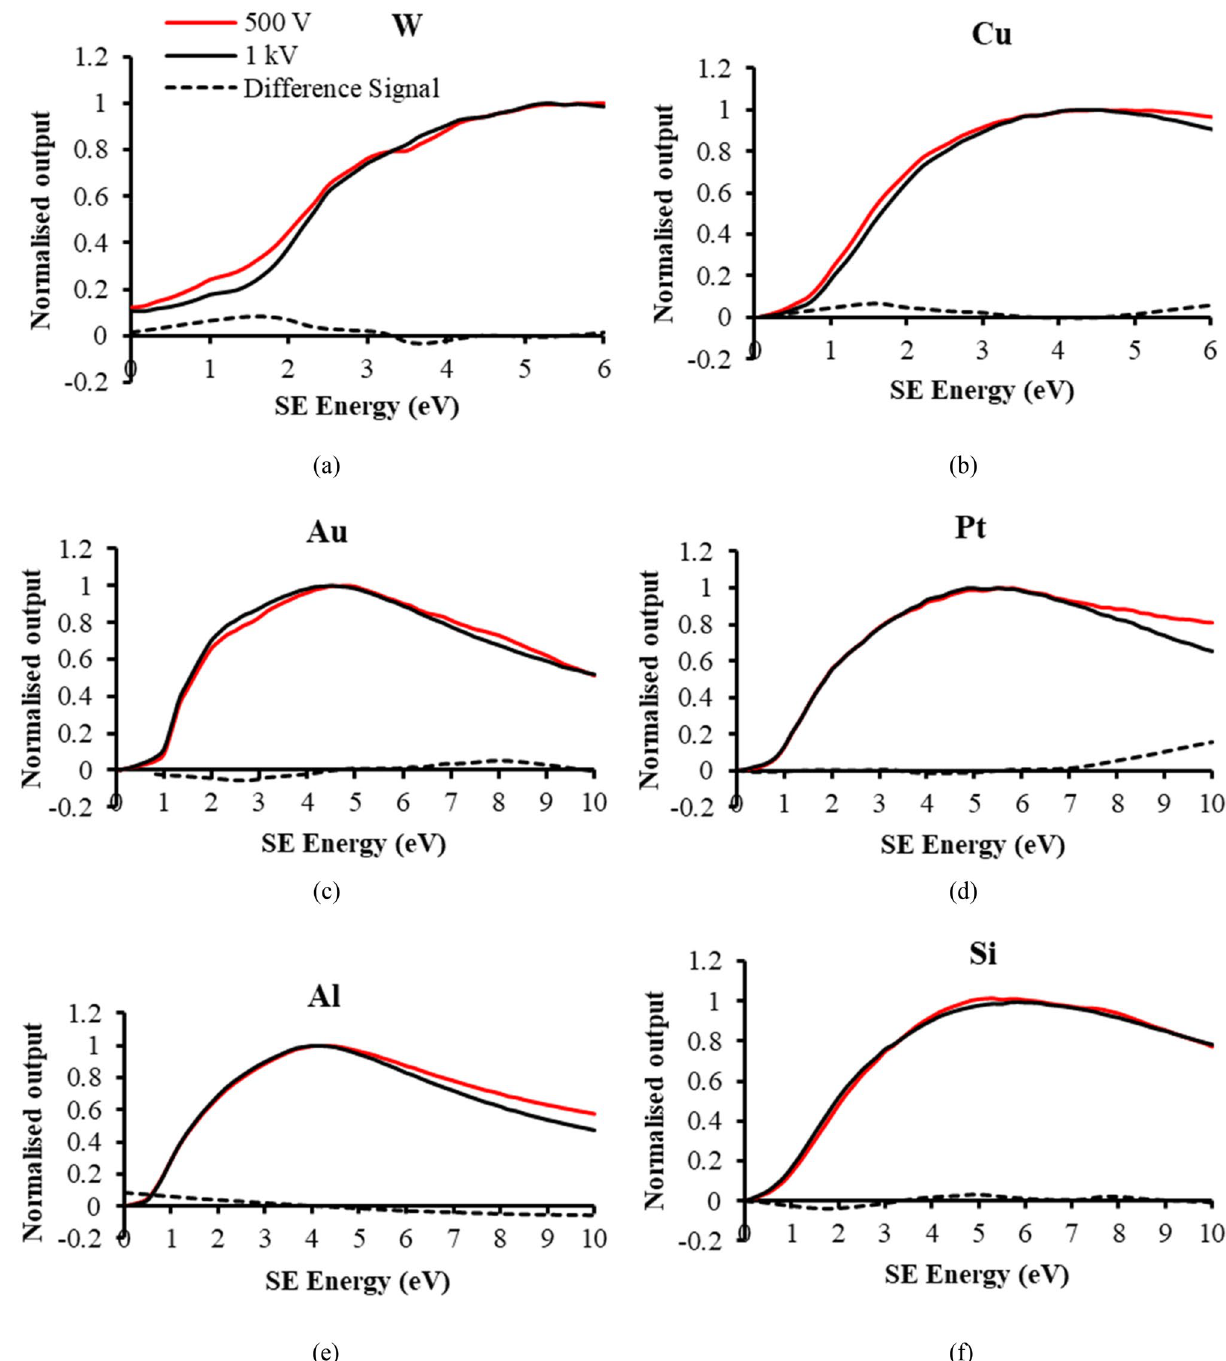
Figure 3. Normalised analyser spectral signals at the primary beam voltages of 1 and 0.5 kV and their difference signals for 6 test specimens: ( a ) W ( b ) Cu ( c ) Au ( d ) Pt ( e ) Al ( f ) intrinsic